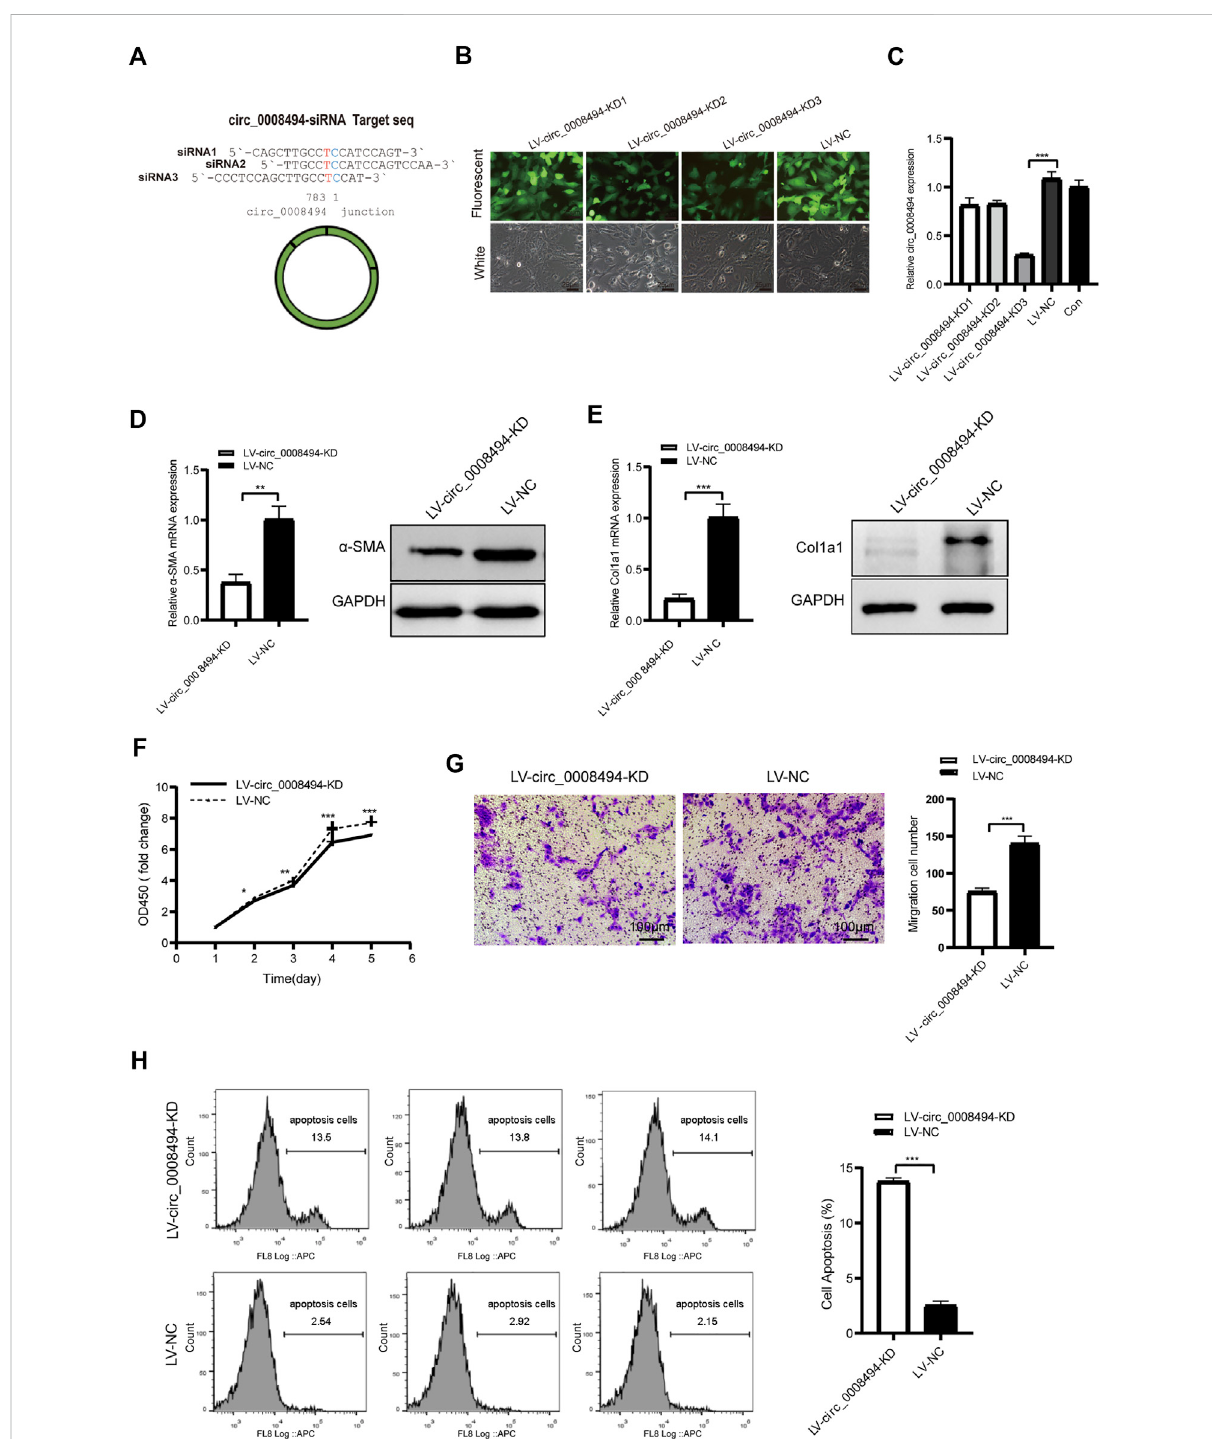
FIGURE 3 circ_0008494knockdowninhibitstheactivation,proliferation,migrationofHSCsandpromotedtheirapoptosis (A) ThreesiRNAstargetingthejunction sequenceofcirc_0008494weredesigned (B) LX-2cellsemittedGFP fl uorescenceaftercirc_0008494-interferingvirusesandNCvirusinfection(400×) (C) qRT-PCRshowedLV-circ_0008494-KD3exhibitedthehighestcirc_0008494reduction(0.30±0.02)vsLV-NC (DandE) ThemRNAandproteinexpression levels of a-SMA and Col1a1 in the LV-circ_0008494-KD and LV-NC groups (F and G) Effect of circ_0008494 knockdown on the proliferation and migrationof LX-2 cells was detectedby CCK8 and transwell assays. InCCK8assay, the ODvalueatday1 wasnormalizedto 1 andthedataareexpressedas fold (H) Apoptosis was detected by Annexin V-APC single staining combined with fl ow cytometry in LV-circ_0008494-KD and LV-NC groups. The RNA levels were normalized to total GAPDH. The protein levels were normalized to total GAPDH. Statistical analysis: Student t -tests. *, **, and *** stand for p < 0.05, p < 0.01, and p < 0.001, respectively. Experiments were repeated independently three